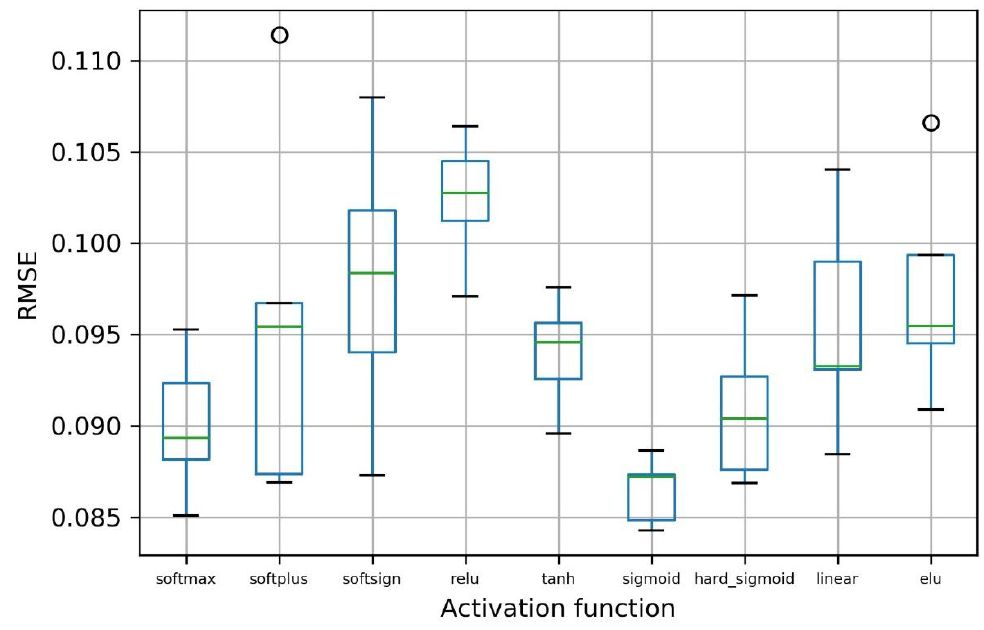
Figure 4. Box-and-whisker plot for activation function selection.